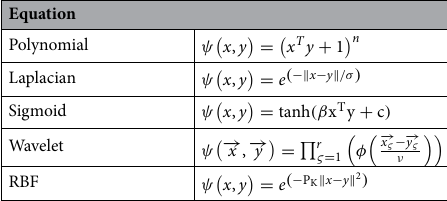
Table 4. Kernel functions with their equations.